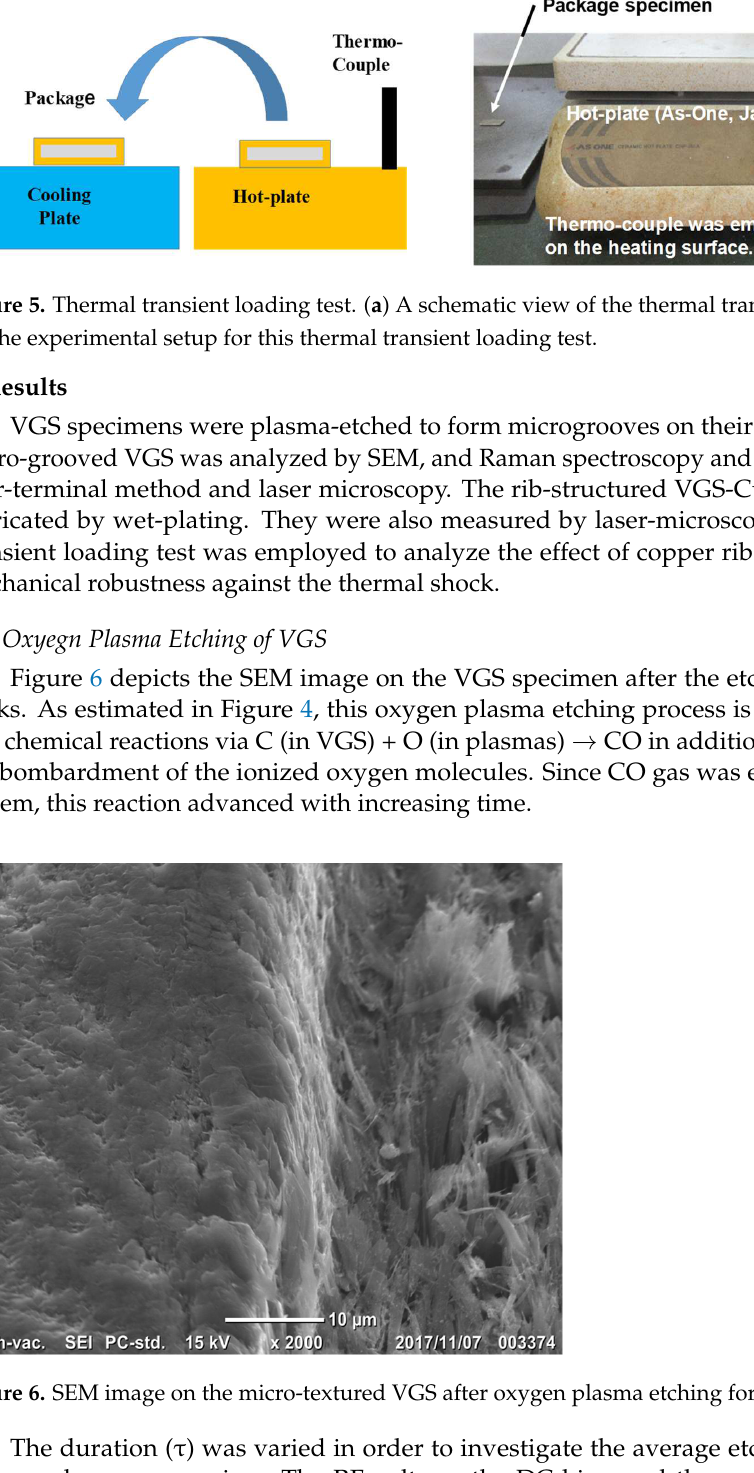
Figure 6. SEM image on the micro-textured VGS after oxygen plasma etching for 7.2 ks. d = 5 μm at τ = 1.8 ks, and d = 26 μm at τ = 7.2 ks. This monotonous etching behavior